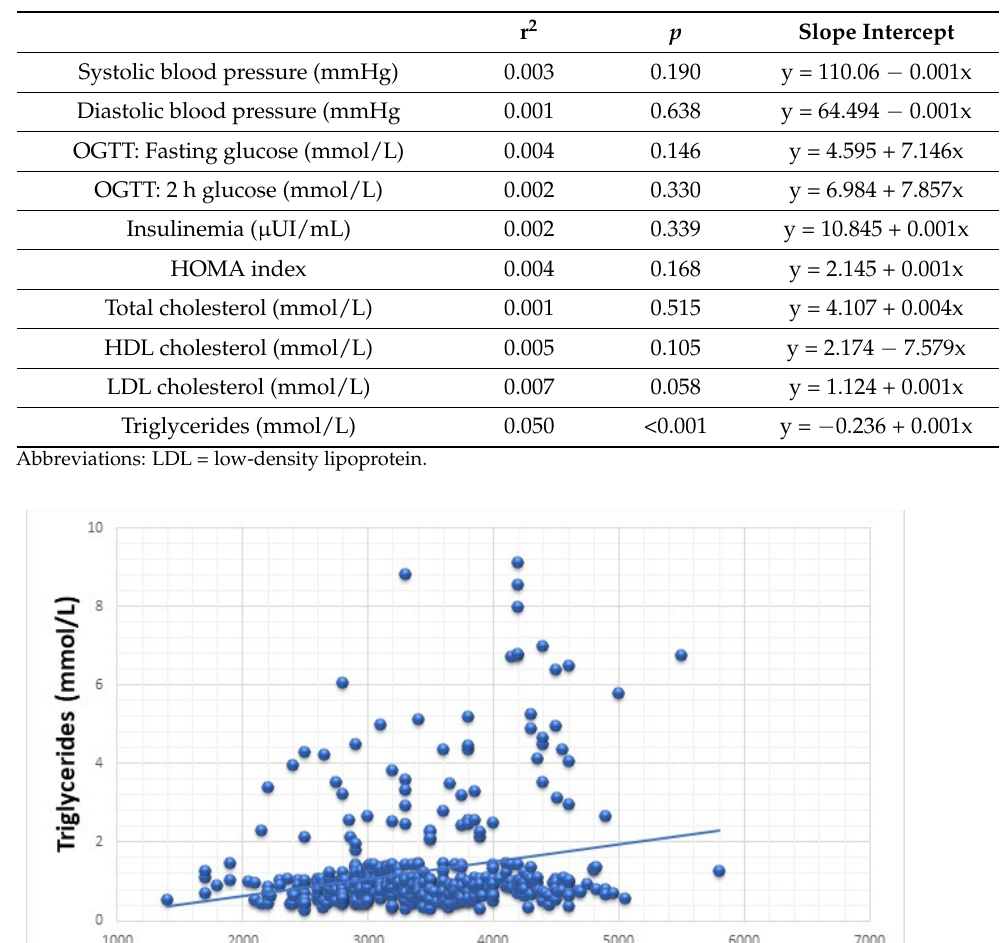
Table 3. Regression analysis versus BW.